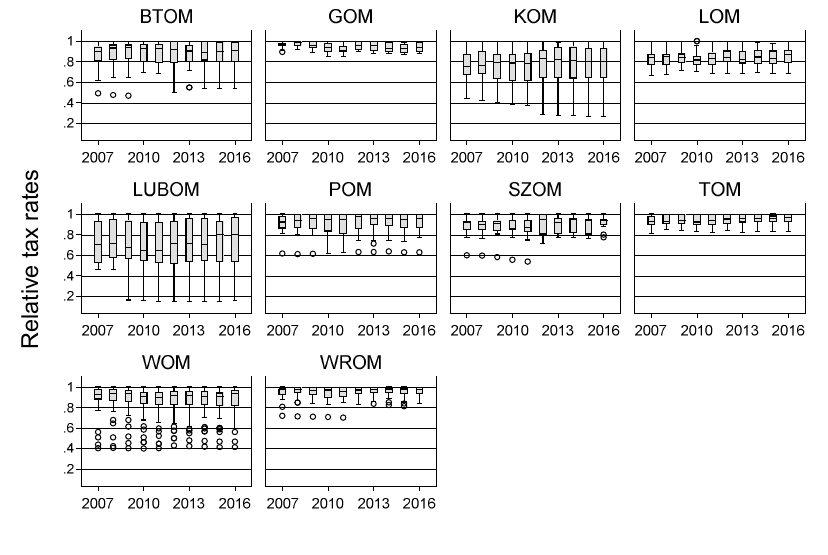
Figure 1. The tax rate on residential buildings from 2007 to 2016 (relative to annual Maximum Rate set by Ministry of Finance, in %)